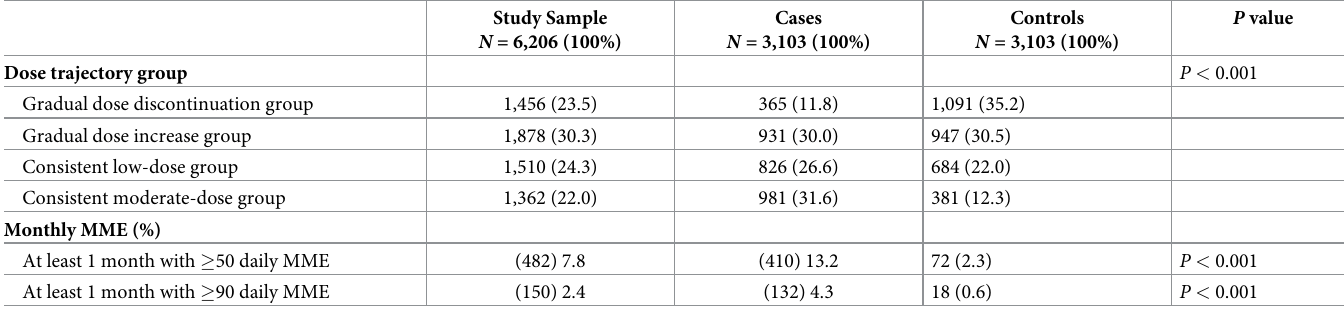
Table 3. Distribution of prescription dose trajectories group and monthly dose in MME in the study sample, cases, and matched